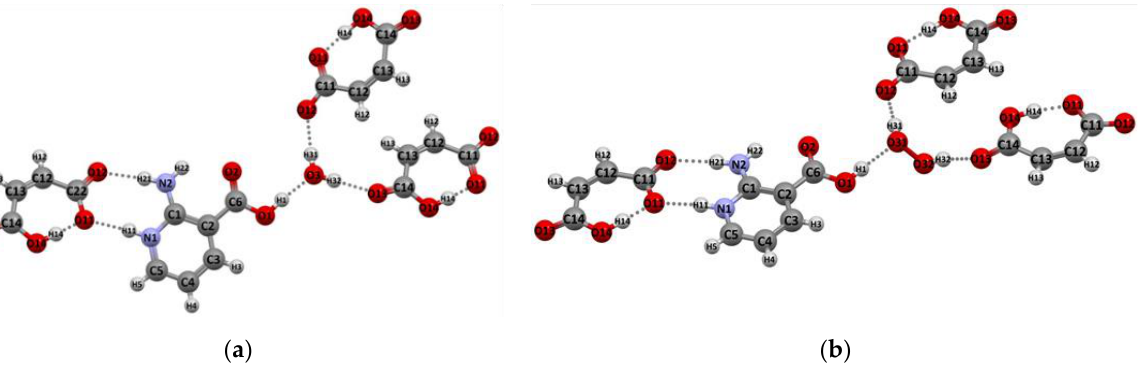
Figure 1. The fragments of the [2AmNic+Mle+H 2 O] [36] ( a ) and [2AmNic+Mle+H 2 O 2 ] ( b ) structures. H-bonds are denoted by dotted lines.